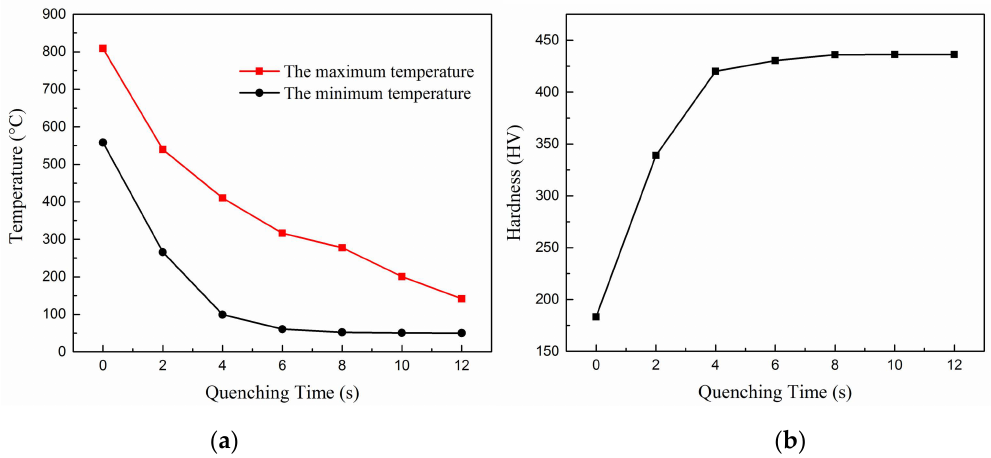
Figure 6. Variation of the temperature ( a ) and hardness with the quenching times ( b ).